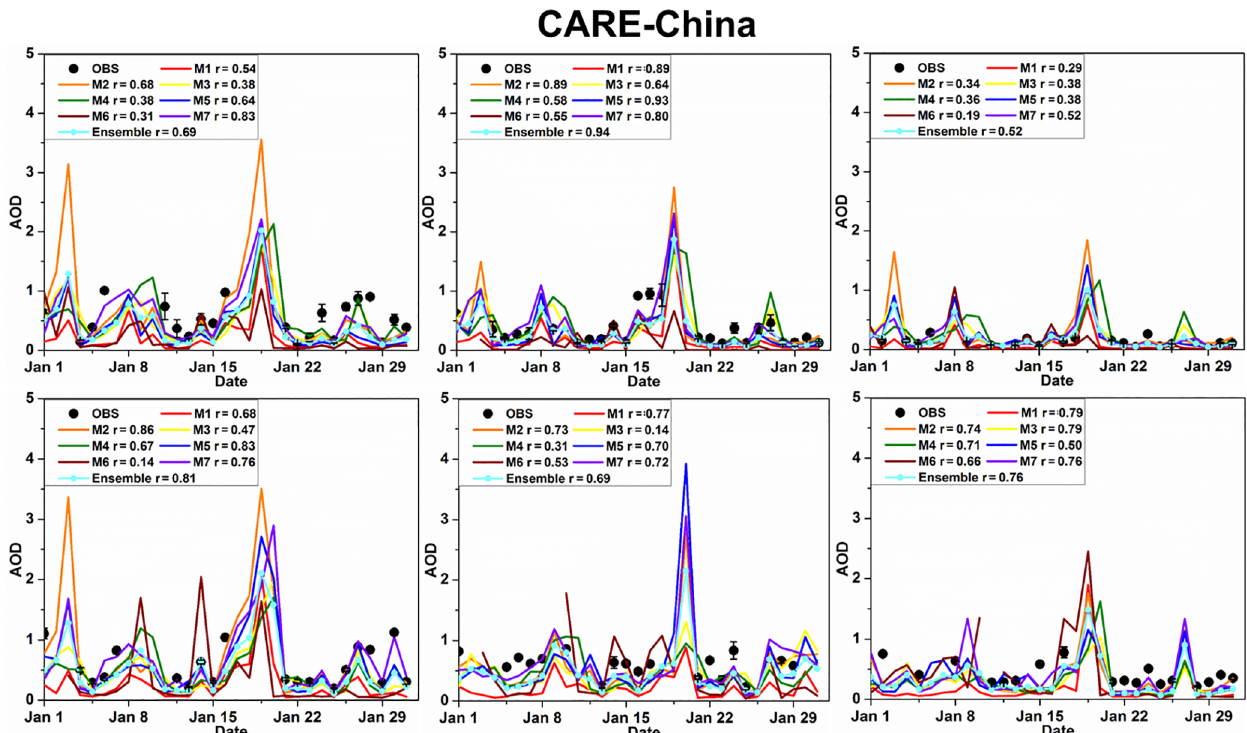
Figure 12. Comparisons between simulated and observed daily (daytime) mean AOD at the CARE-China sites (Baoding, Beijing City, Beijing Forest, Cangzhou, Jiaozhou,